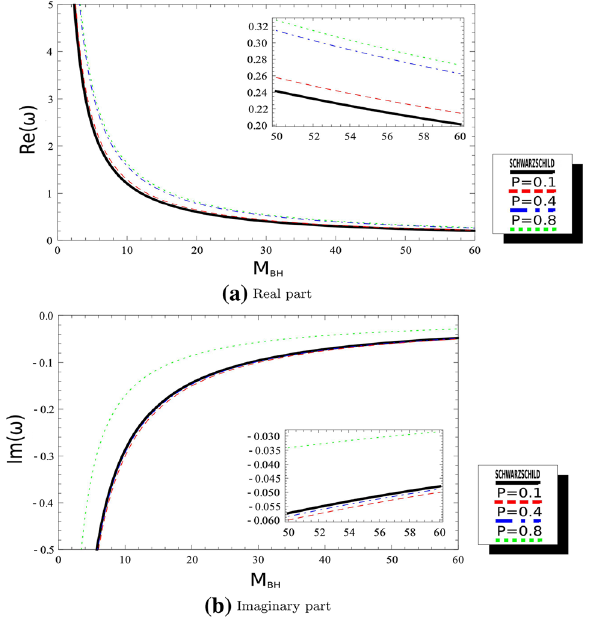
Fig. 8 Imaginary and Real part of ω for l = 2, n = 0, and P = 0 . 1, P = 0 . 4, P = 0 .